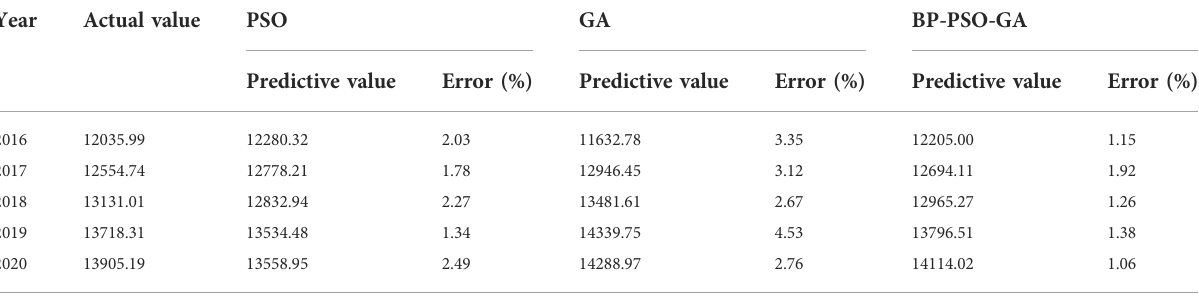
TABLE 4 Analysis of training sample prediction results.